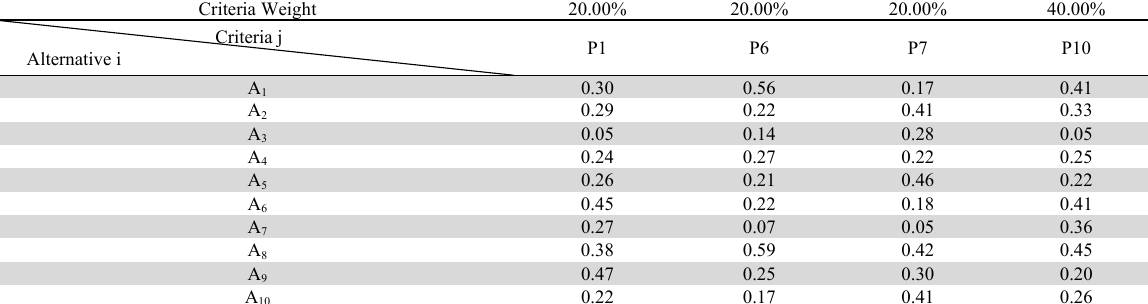
Criteria Weight